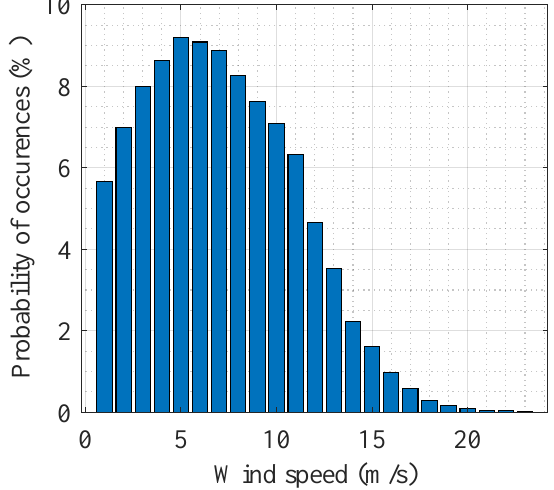
Figure 8. Wind speed percentage